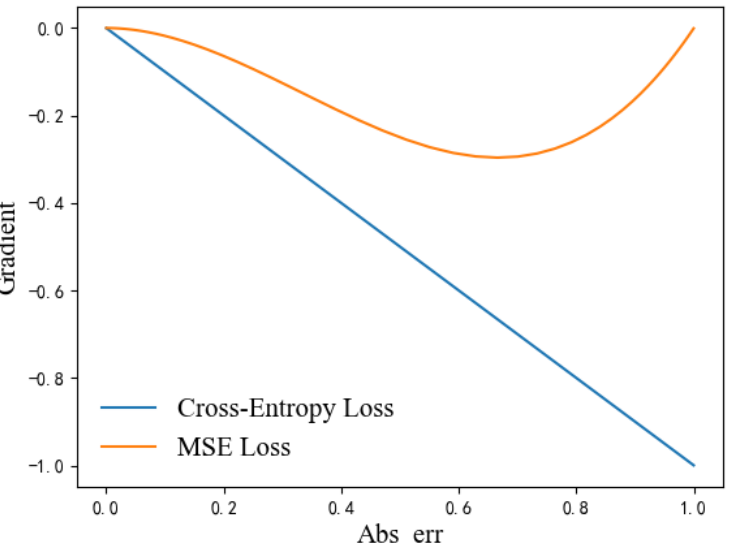
Figure 5. The relationship between the training gradient and the absolute